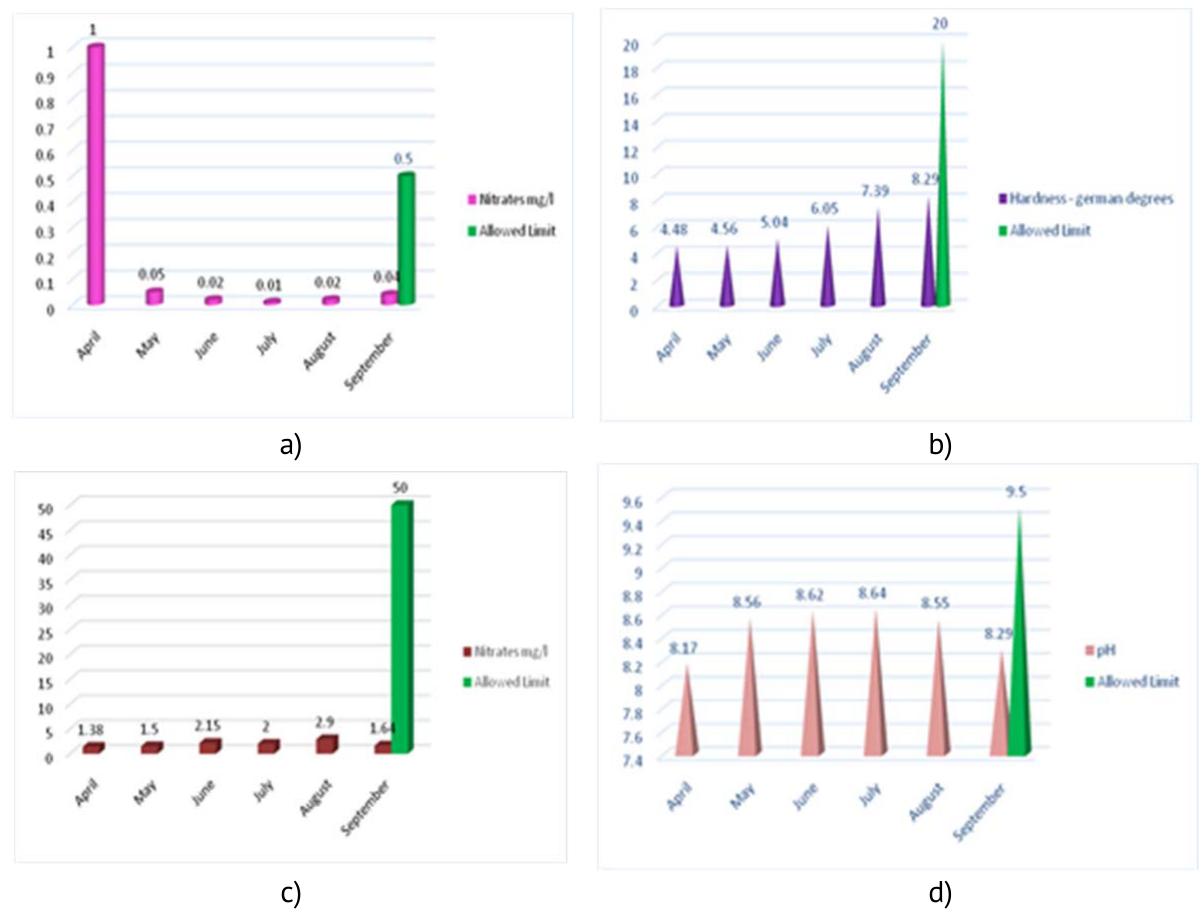
Figure 1. Control results for nitrites (a), nitrates (b), of hardness (c) and pH (d) in drinking